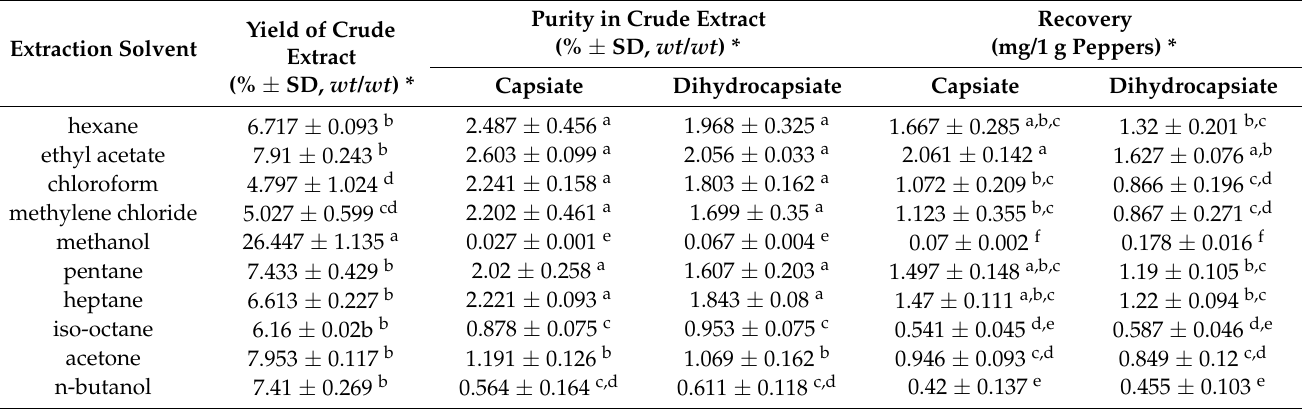
Table 1. Efficiency of solvents on the extraction and recovery of capsinoids from dried fruit of Capsicum annum (509-45-1) following triplicate